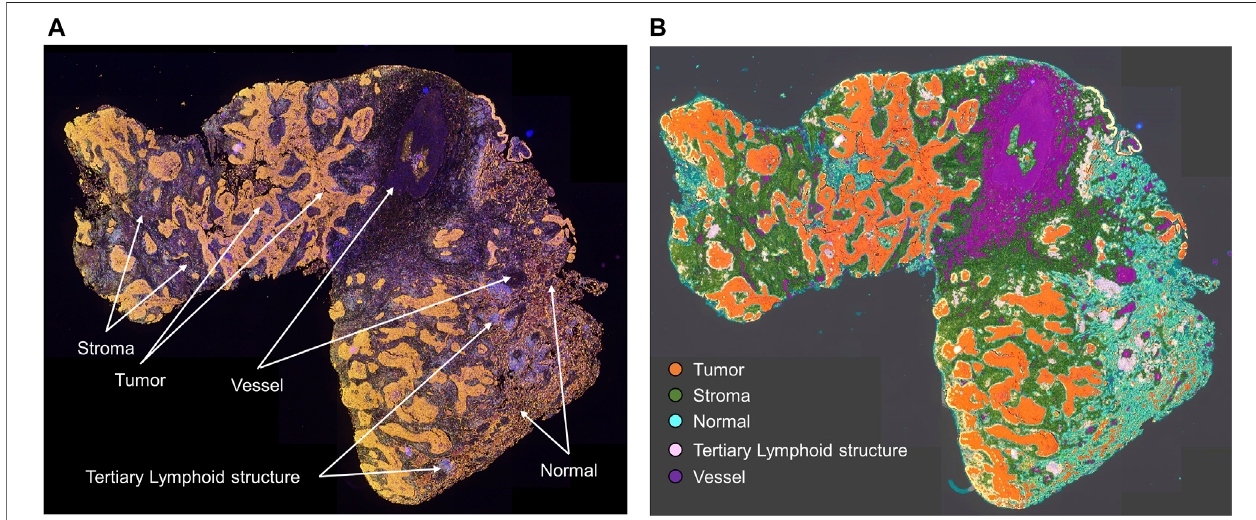
FIGURE 1 | Microphotographs of a representative whole tumor section of lung squamous cell carcinoma obtained using multiplex immuno fl uorescence staining. (A) Geographic distribution of cells in different tissue compartments. (B) The geographic compartments were delineated using HALO image analysis software (Indica Labs, Albuquerque, NM) to analyze cells in different compartments. Original magni fi cation, × 4.